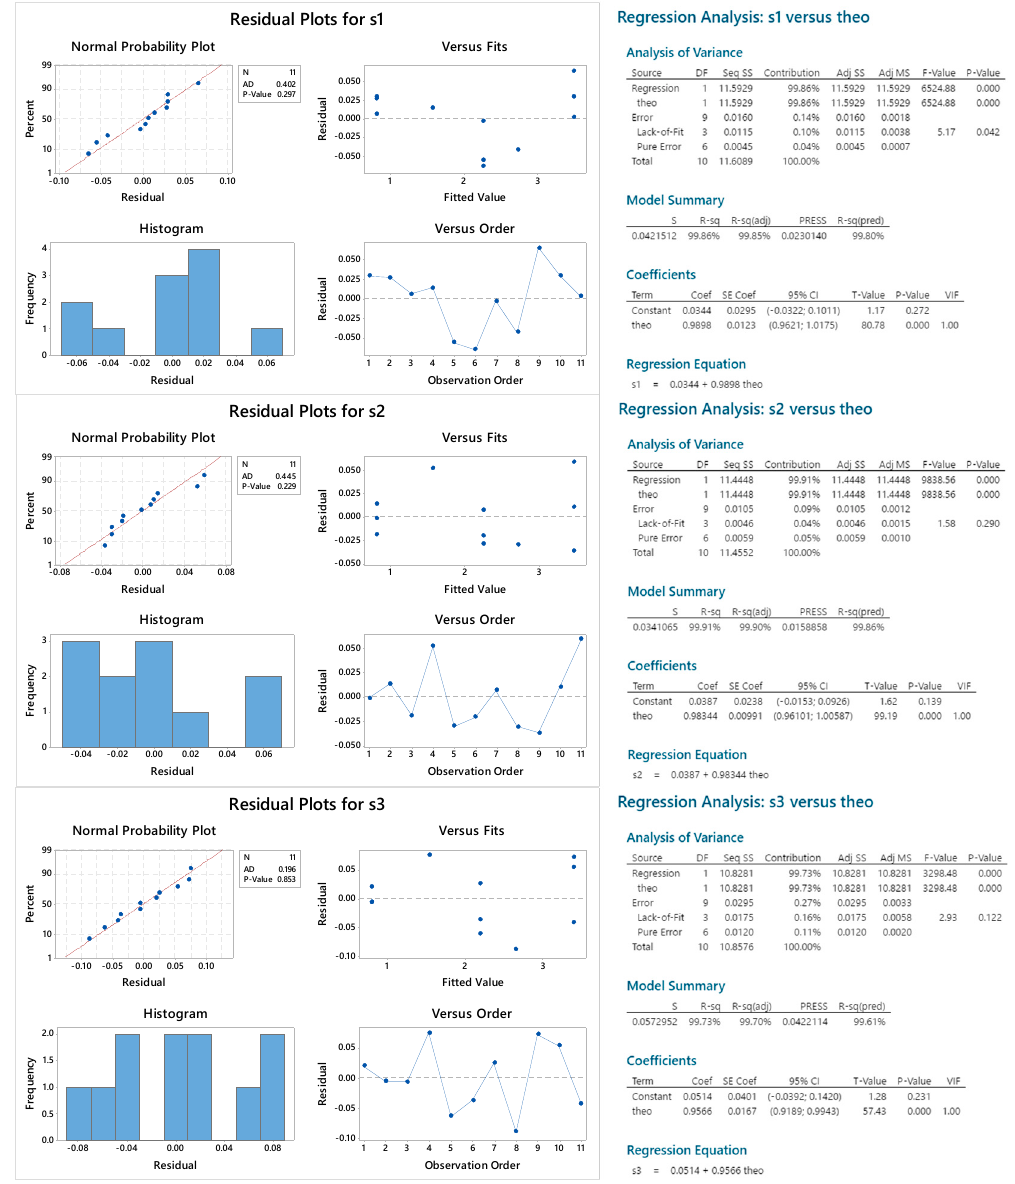
Figure A17. Linear regression analysis for sample Linearity determination for quantification of S. flexneri 6 OAg by HPAEC-PAD (data from single analysis session #1–3).